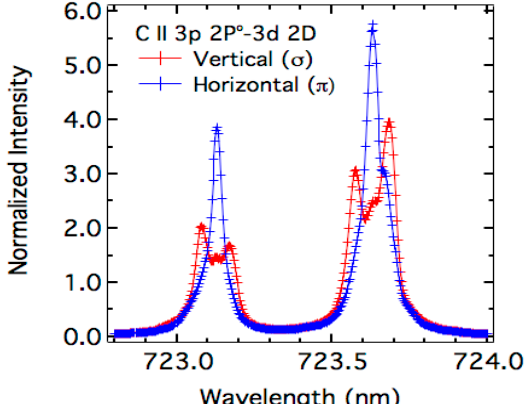
Figure 8. Experimental spectra of the C II 723-nm line as measured in LHD almost perpendicularly to the magnetic field (see Figure 1) using a very high-resolution visible spectrometer and linear